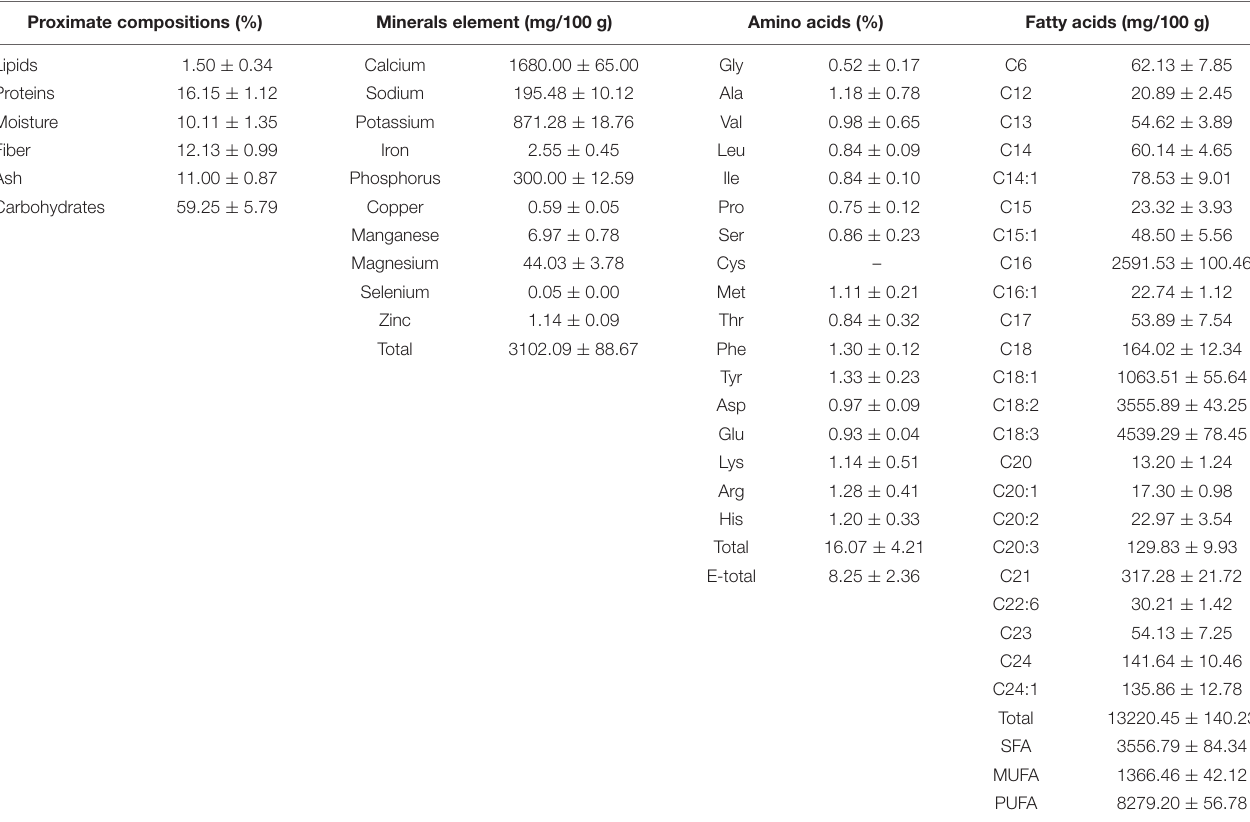
TABLE 1 | The proximate compositions, minerals compositions, amino acids and fatty acids of the aerial parts of Adonis coerulea . Proximate compositions (%) Minerals element (mg/100 g) Amino acids (%) Fatty acids (mg/100